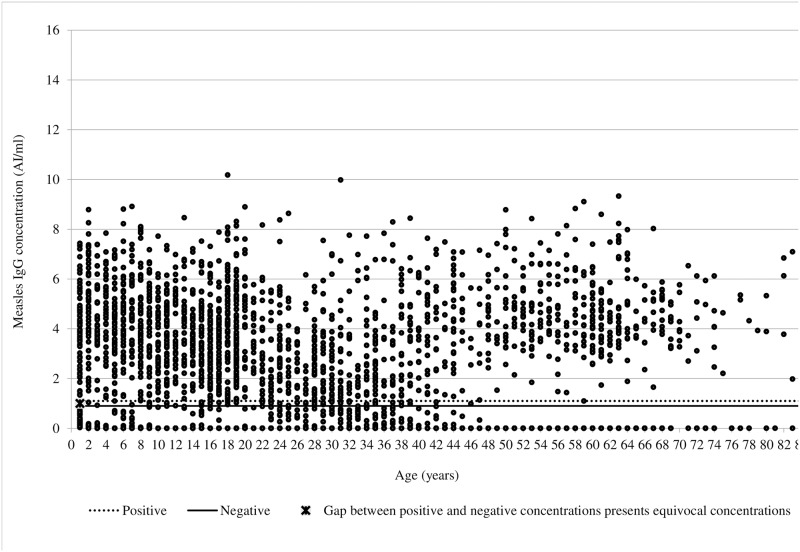
Scatter plot of measles IgG concentration (AI/ml) by age in Vojvodina, Serbia, 2015–2017.